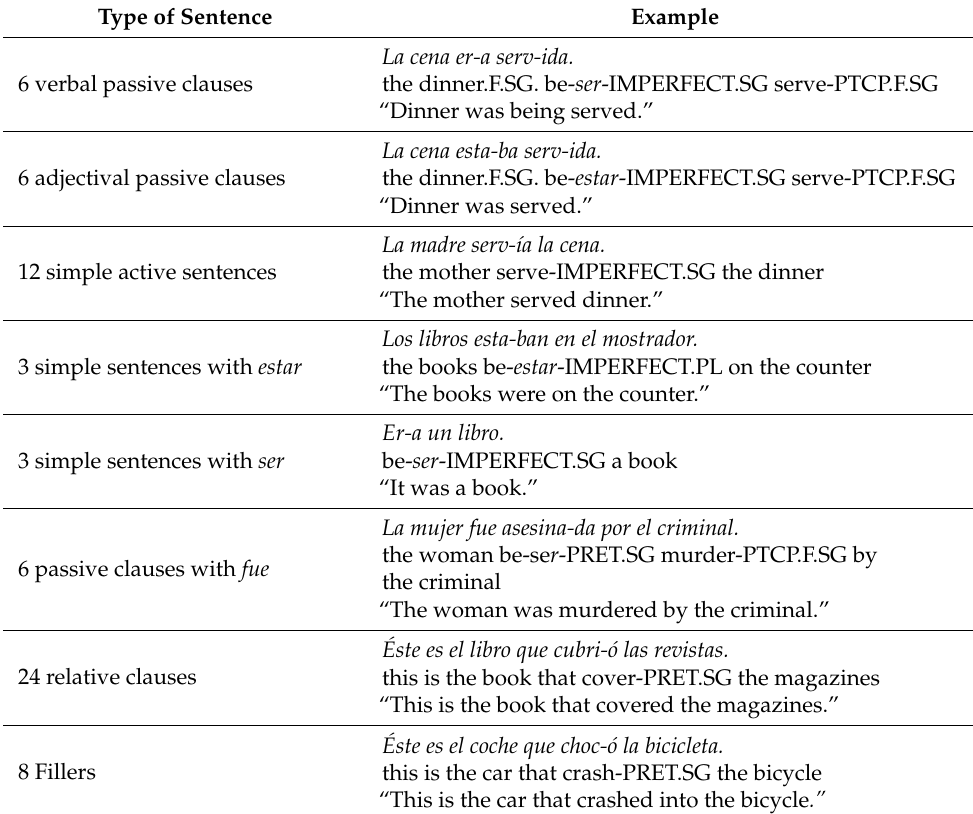
Table 2. Picture-matching task (PMT) sentences in each script (not including practice